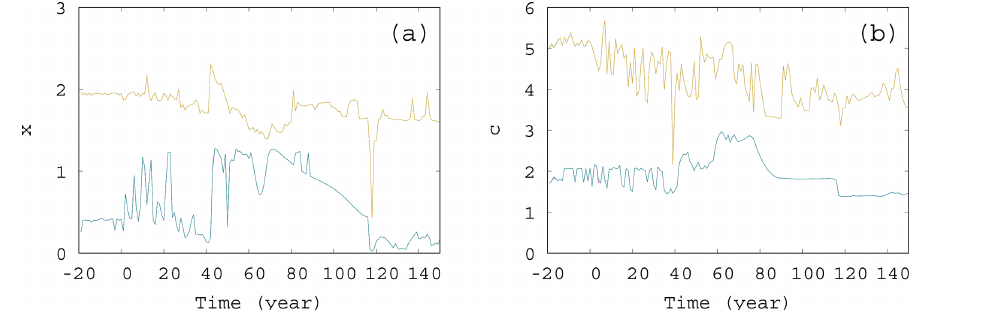
Figure 11. The extremes of the snapshot attractor for α = 0 . 05, β = 0 . 1, and γ = 0 . 1. Only 10% of the points are found above (below) the higher (lower) values for each time instant for (a) x and (b) c